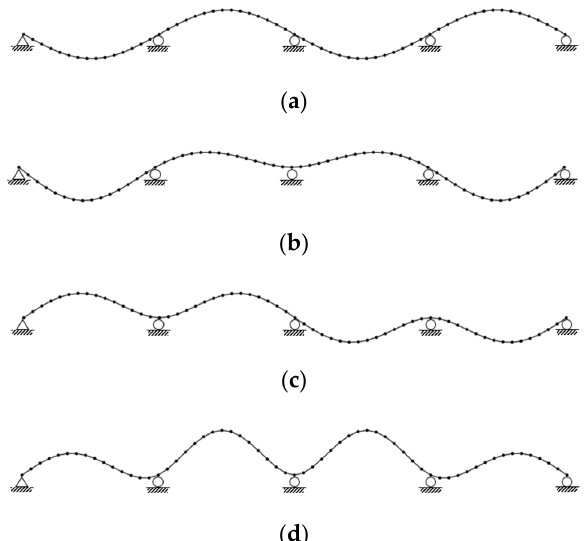
Figure 7. Examples of mode shape function (MSF) derived by frequency analysis (beam): ( a ) MSF1,